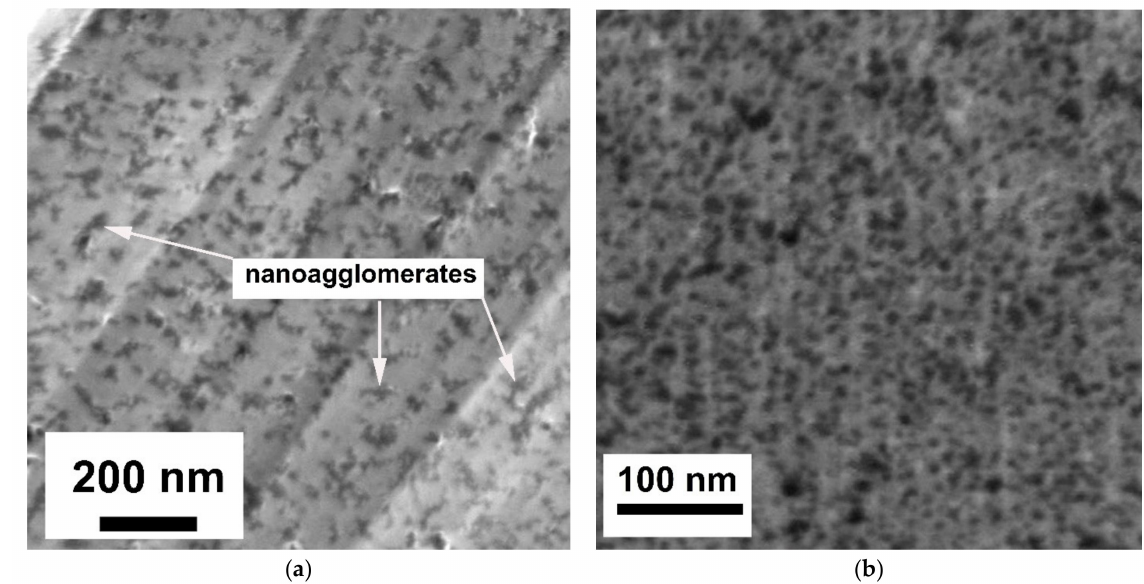
Figure 2. Nanodiamonds inside metal matrix: ( a ) nanoagglomerates; and ( b ) non-agglomerated distribution of nanodiamond-reinforcing particles in metal matrix from aluminium and copper.